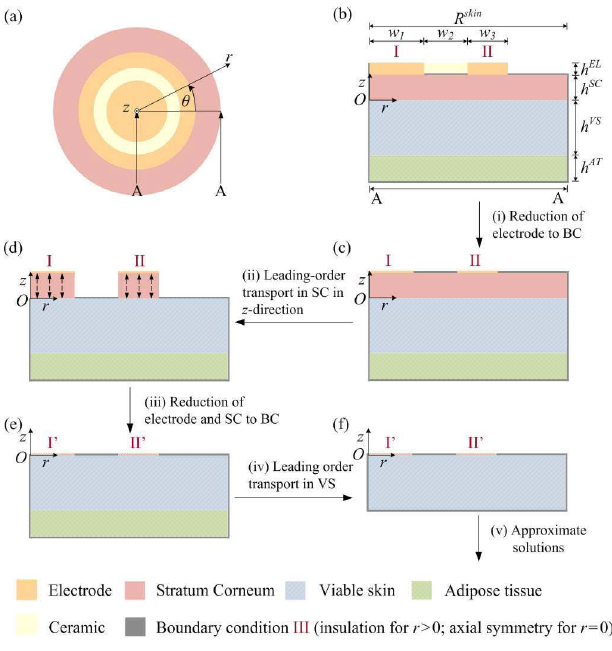
Fig.1: Schematic overview of the non-invasive two-electrode EIS probe and adjacent stratum corneum, viable skin and adipose tissue (a-b). The model reduction from the scaling analysis is illustrated in